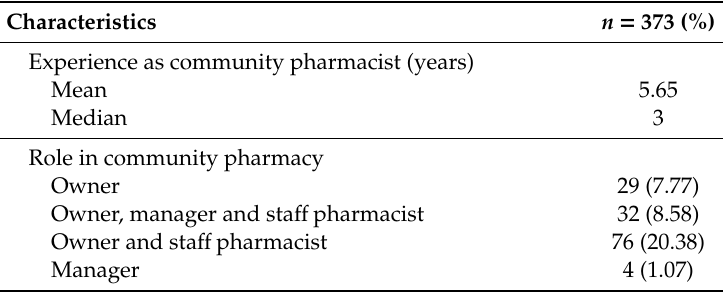
Table 5. Employment Detail of the